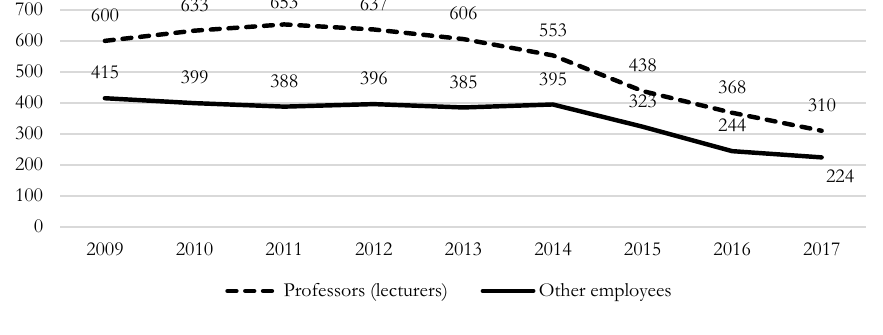
Fig. 11 – Mykolas Romeris University staff (number of employees). Source: Mykolas Romeris University